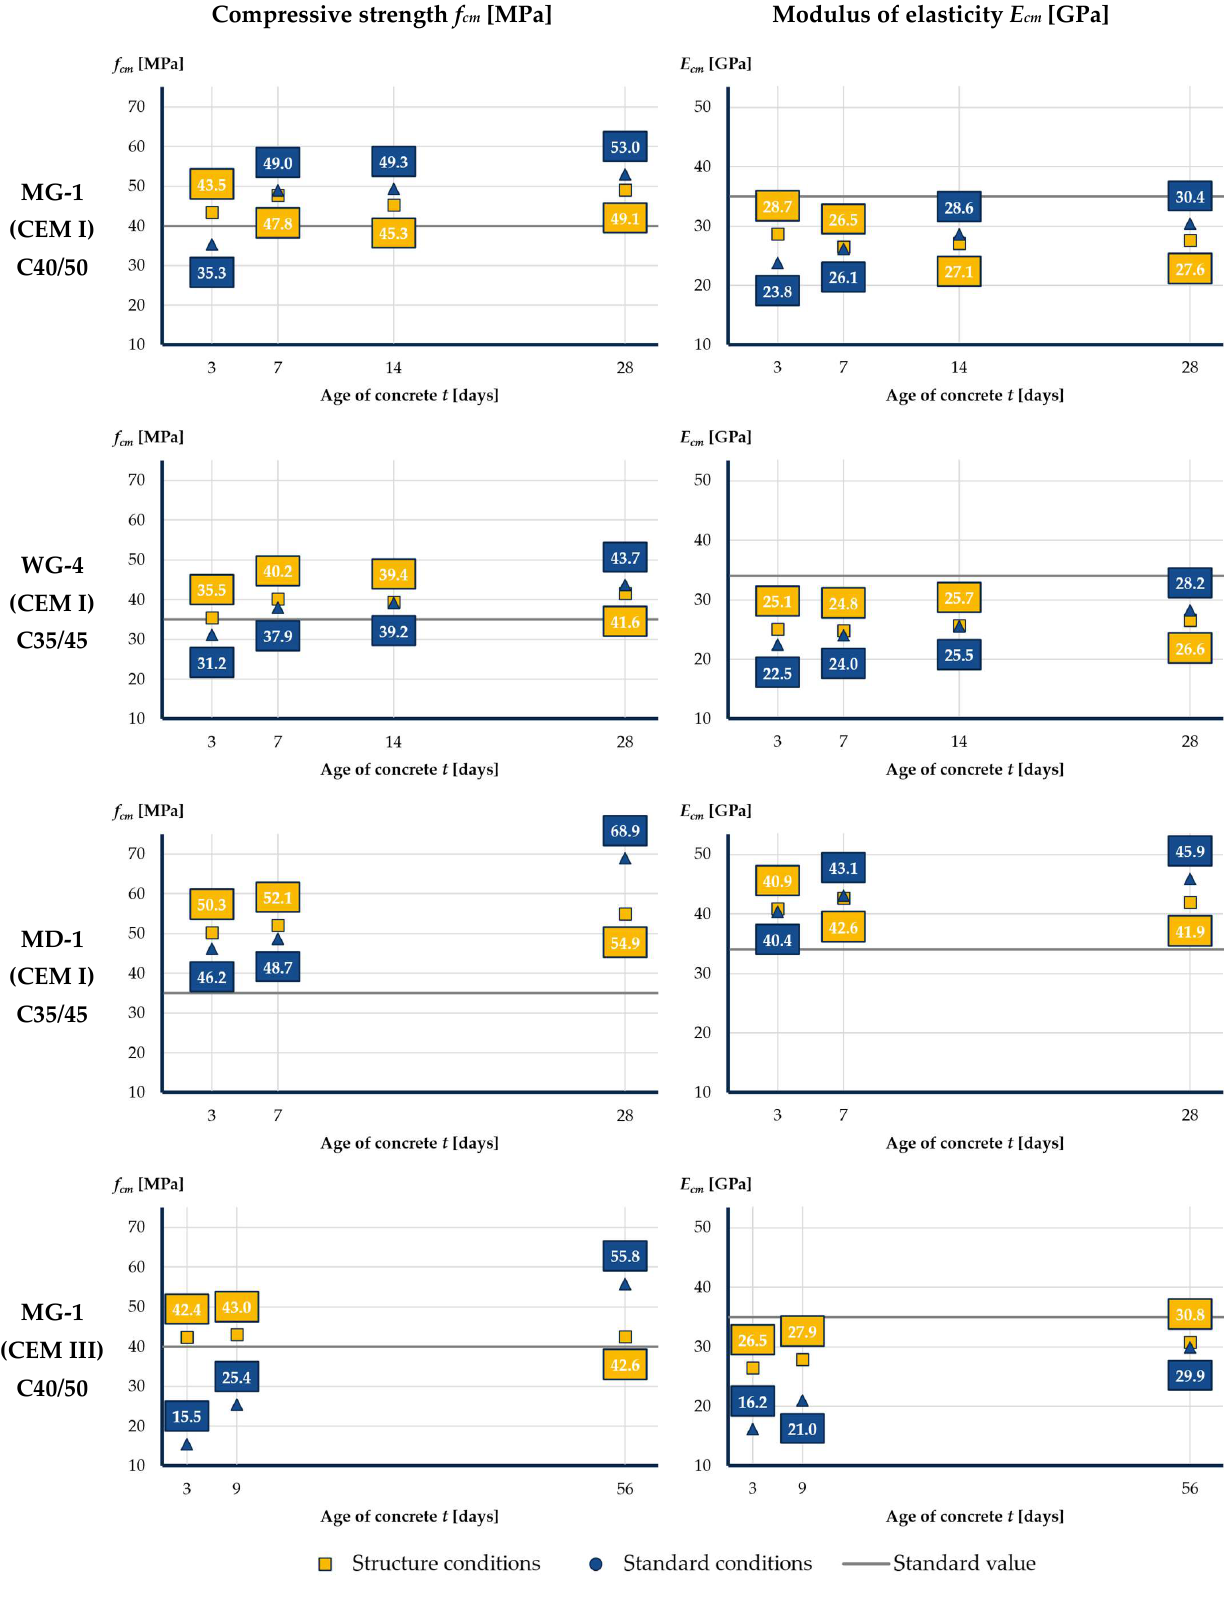
Figure 8. Compressive strength and modulus of elasticity of concrete over time, taking into account curing